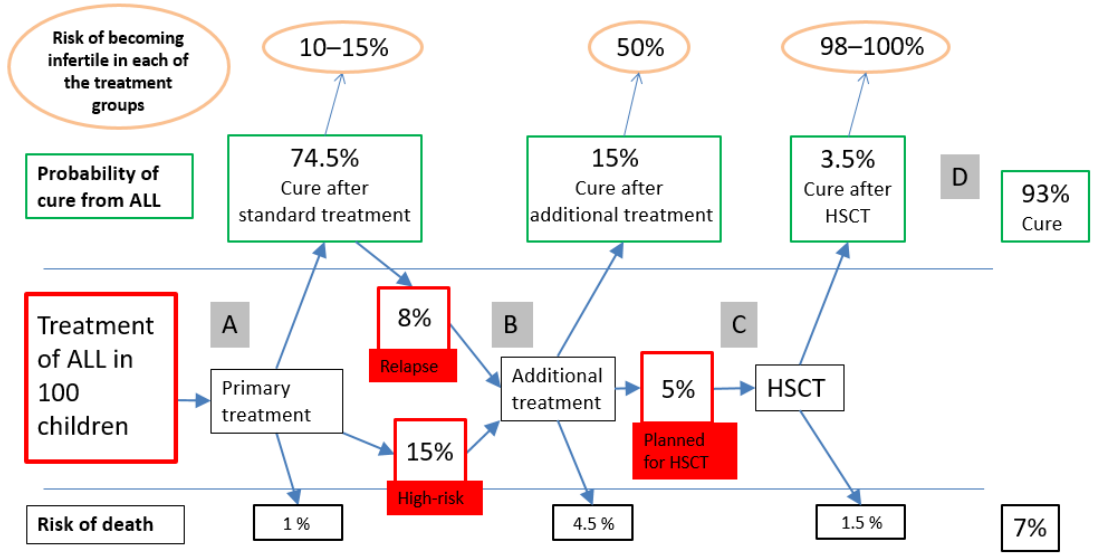
Figure 2. Possible time points (A–D) for fertility preservation of children presenting with acute lymphocytic leukemia (ALL). Reprinted with permission from Borgström et al. Pediatr Blood Cancer . 2020, 67, e28507. HSTC = hematological stem cell transplantation [17].